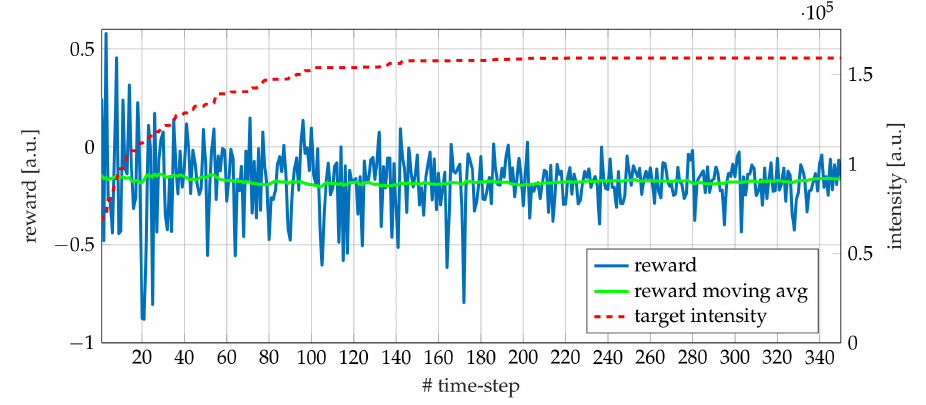
Figure 8. Reward (blue), moving average of reward (green) with a fixed window size of 50 samples and target intensity (red, dashed) during a single run of NPG REINFORCE on EOS. The target intensity increases each time a reward greater than zero is